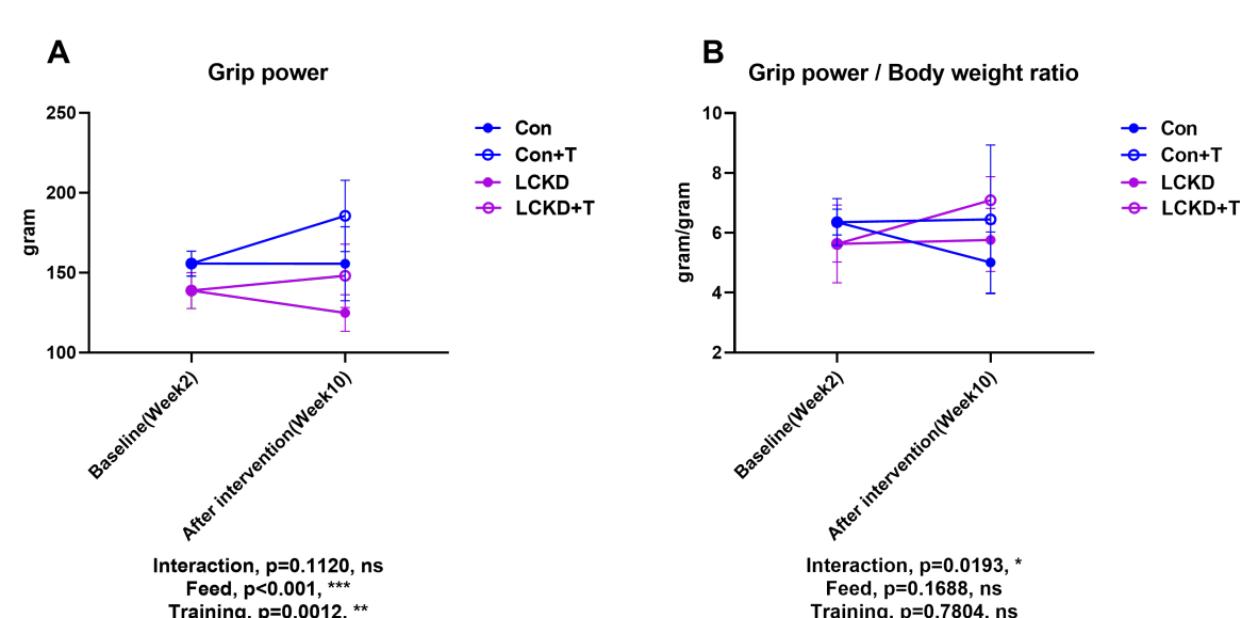
Figure 3. Forelimb grip power. ( A ) Absolute grip power and ( B ) grip power corrected by body weight. Con, Con + T, LCKD, and LCKD + T stand for chow diet, chow diet plus training, low-carbohydrate ketogenic diet, and low-carbohydrate ketogenic diet plus training, respectively. Feed indicates a main effect of diet, training indicates a main effect of treadmill exercise, and interaction indicates the interactive effect between feed and training. ns, no significance observed. * p < 0.05, ** p < 0.01, and *** p < 0.001. A two-way analysis of variance (ANOVA) was performed to determine the effects of diet, training, and interaction. When ANOVA indicated a significant effect, a Tukey’s post hoc test was performed to determine the significance of differences between means. Statistical significance was set at p < 0.05. Data are presented as the mean ± standard deviation (SD). n = 8 for each group.